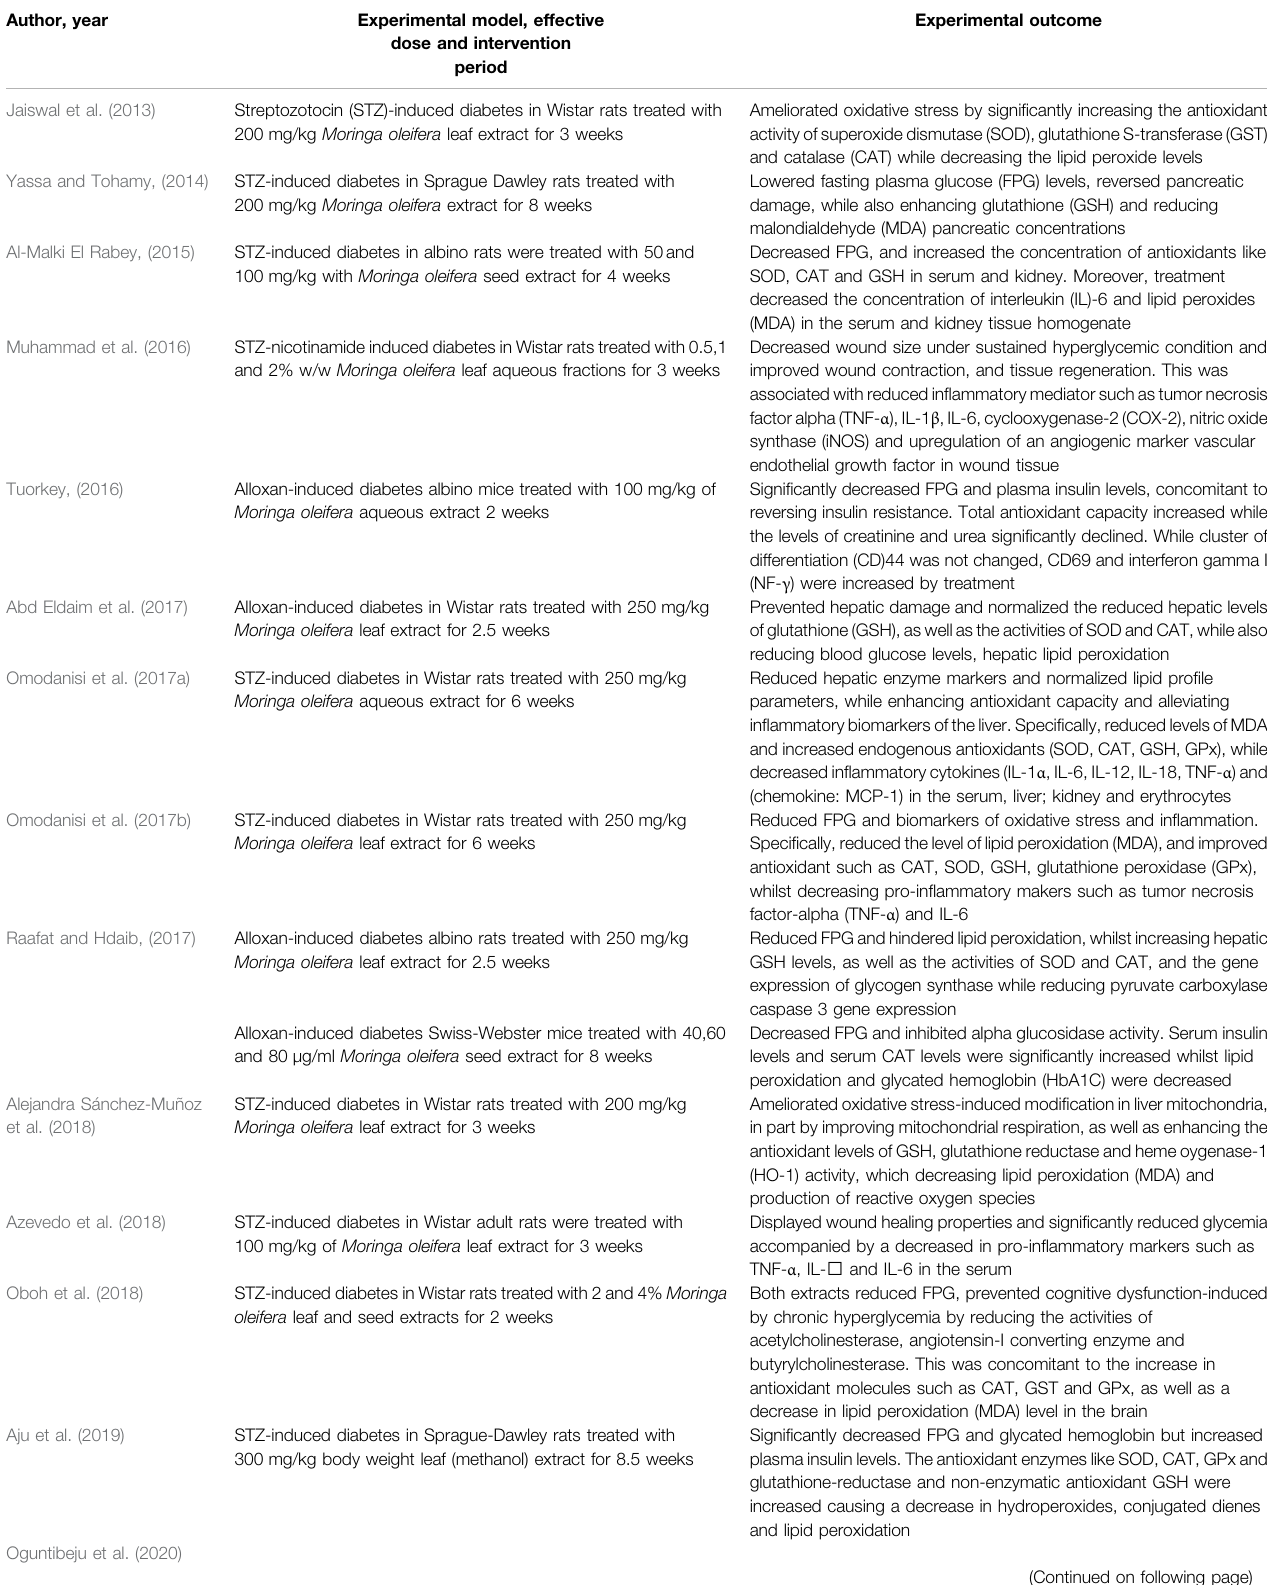
TABLE 1 | Studies on the effect of Moringa oleifera extracts targeting markers of oxidative stress and in fl ammation in preclinical models of type 1